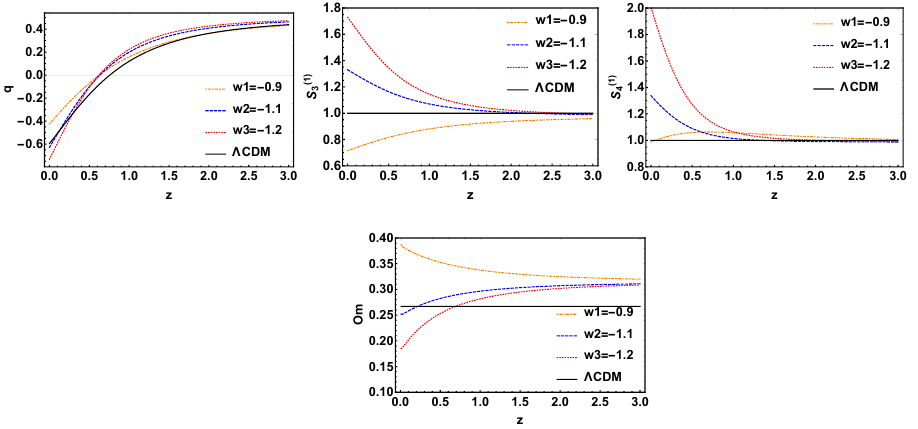
( 1 ) ( 1 ) , S and Om , respectively, versus red shift z for the 3 4